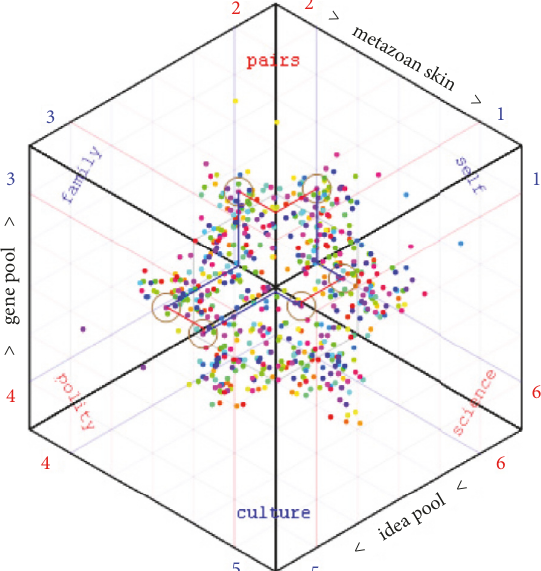
Figure 3: Six projections of 100-member random simplex point- picked dot-cloud, with projections of one individual organism circled. The attention-fraction associated with the outer vertices is labeled, while the central vertex in each ternary-plot triangle represents the sum of the remaining fractions.